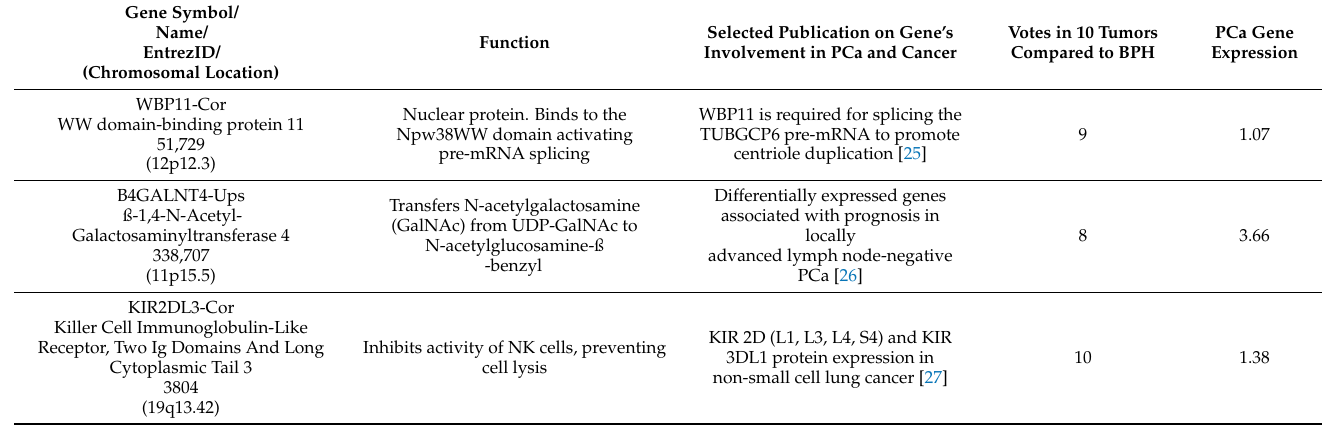
Figure 1. DNA methylation heat maps of CpG-rich 5 (cid:48) gene regions from PCa biopsies (G7, 3 + 4) and PCa primary tissue samples (G7, 4 + 3) compared to BPH reference samples. Five tissue samples from BPH prostate glands, five mixed tissue samples of tumor and tumor-adjacent tissue (mixed tu/tu adj.; 50/50%), five samples of tumor-adjacent gland tissue (tumor adjacent) and five tumor tissue samples (tumor, >90%) were used. The left panel corresponds to biopsy samples and the right panel shows the results of primary PCa tissue samples. Only the first 30 most-voted differentially methylated loci out of 237 hypomethylated regions in the biopsies and 202 hypomethylated regions in the primary tumors are presented in each case. Each rectangle in the heat map stands for one CpG-rich 5 (cid:48) gene region, with its chromosomal location indicated on the right-hand side (Chr, start/end). The “votes” number indicates how many of the samples were found with hypomethylation of the respective region by the democratic method. Redder color corresponds to more methylated regions. I.e., the most unmethylated 5 (cid:48) gene regions are light blue. The grade of methylation is also indicated by numbers within the colored rectangles. Higher number corresponds to higher methylation. The abbreviation “Cor” after the gene name indicates an examined CpG-rich region of − 500 to +500 nucleotides surrounding the transcription start site (TSS). A further examined region of − 1500 to − 500 bases lying upstream of the TSS is referred to as “Ups” following the gene name. Table 1. Genes found hypomethylated in three different patient cohorts. Selected genes which were found hypomethylated in all three heat map analyses of hypomethylation are presented in Figures 1 and 2. They were selected by consistency of occurrence in these three patient sample cohorts from two different clinical centers (No. 1 and No. 2) and the existing evidence in the literature for their involvement in PCa and cancer in general. The number of votes, calculated by the democratic method, is the number of hypomethylated tumors from 10 tumor samples compared to the average methylation in 5 BPH samples. The gene expression in PCa according to The Cancer Genome Atlas (TCGA) PCa expression data bank [23,24] is also